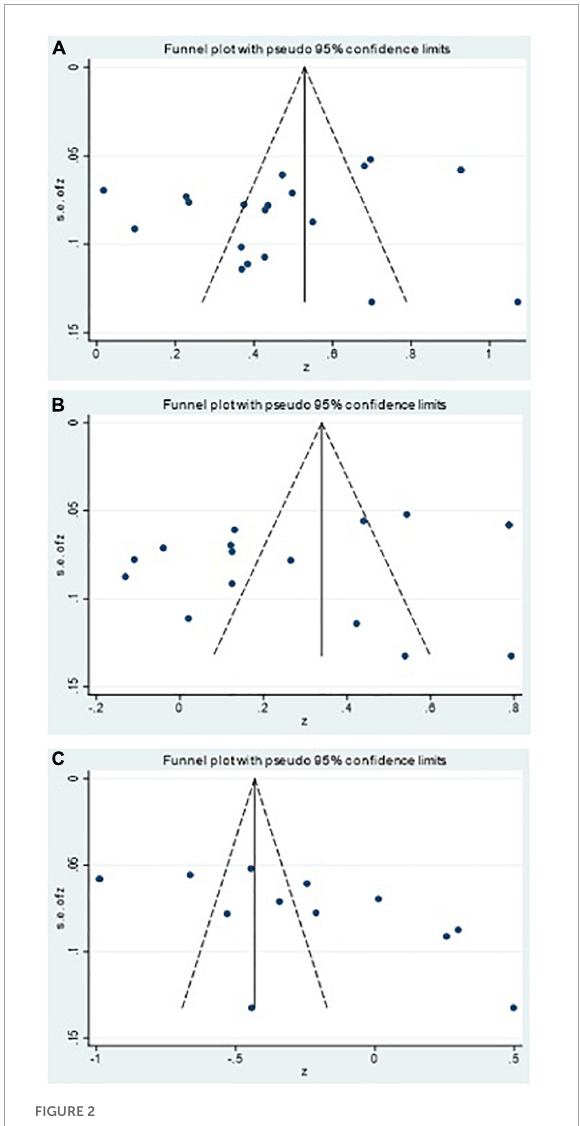
FIGURE2 Funnel plots of the relation of posttraumatic growth and (A) confrontation, (B) avoidance, and (C)